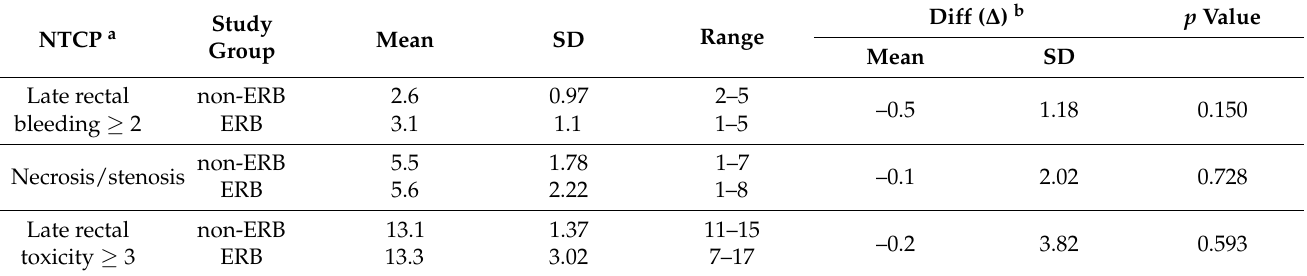
Table 4. NTCP results for the whole rectum comparing between the non-ERB plans and ERB plans.